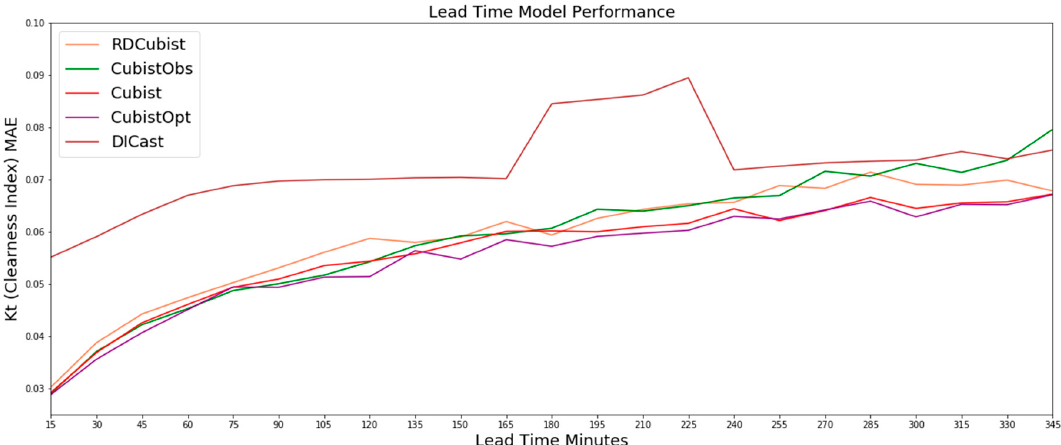
Figure 3. The results on the test dataset for the Cubist-based methods and the DICast ® forecasts, which show that the CubistOpt (green line) method generally performs the best of the three methods while the RD-Cubist (blue line) generally performs the worst of the three methods.